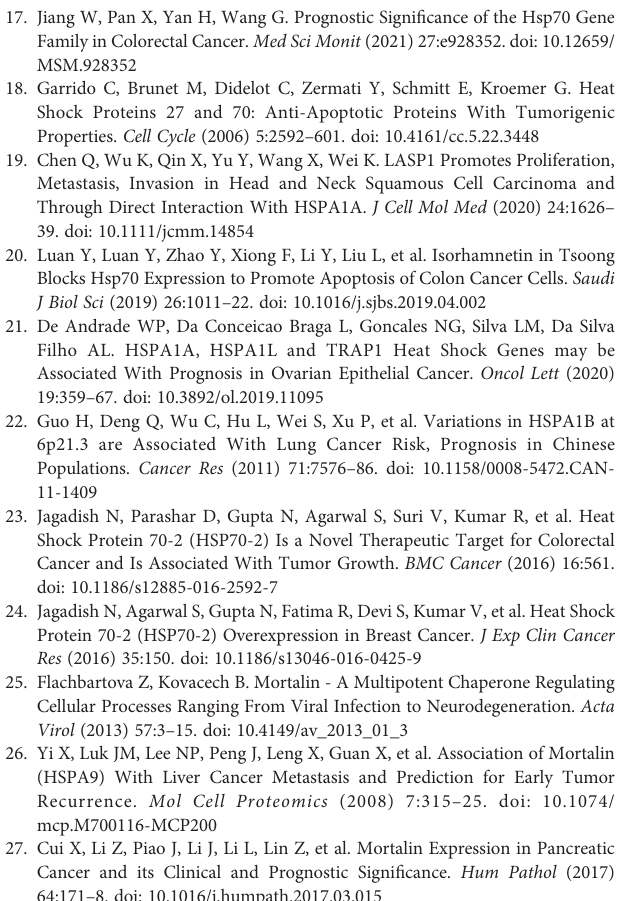
Supplementary Figure 3 | Survivals analysis of patients with different HSPA family member expression levels by Kaplan-Meier method. (A) Overall survival for HSPA2. (B) Overall survival for HSPA4. (C) Overall survival for HSPA5. (D) Overall survival for HSPA6. (E) Overall survival for HSPA8. (F) Overall survival for HSPA12A. (G) Overallsurvivalfor HSPA12B. (H) Overall survivalfor HSPA13. (I) Overall survival for HSPA14. (J) Progress free interval for HSPA2. (K) Progress free interval for HSPA4. (L) Progress free interval for HSPA5. (M) Progress free interval for HSPA6. (N) Progress free interval for HSPA8. (O) Progress free interval for HSPA12A. (P) Progress free interval for HSPA12B. (Q) Progress free interval for HSPA13. (R) Progress free interval for